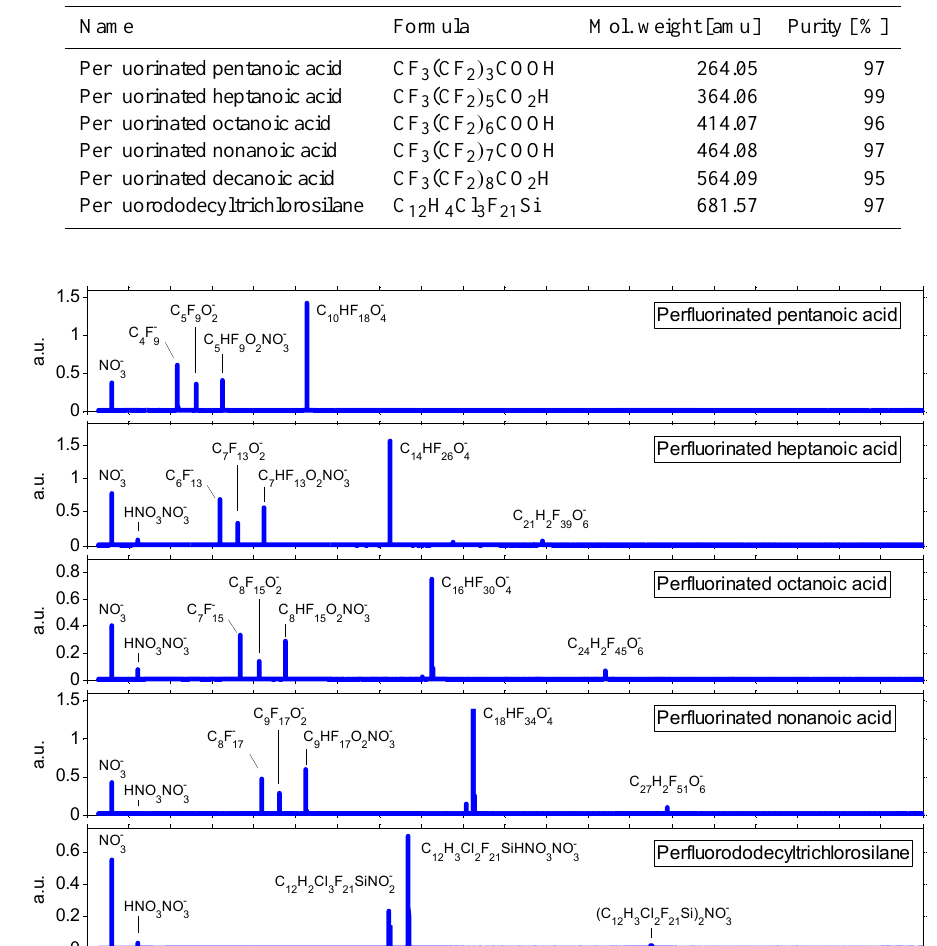
at 62Th and HNO 3 NO − at 125Th. The 3 3 (middle peak), clustering with NO − (right peak) and 3 3